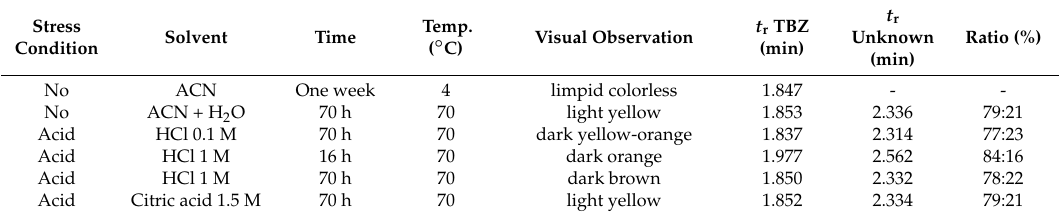
Table 1. Acidic hydrolytic stress conditions applied for tetrabenazine (TBZ) and ratio (%) of observed TBZ/Unknown in